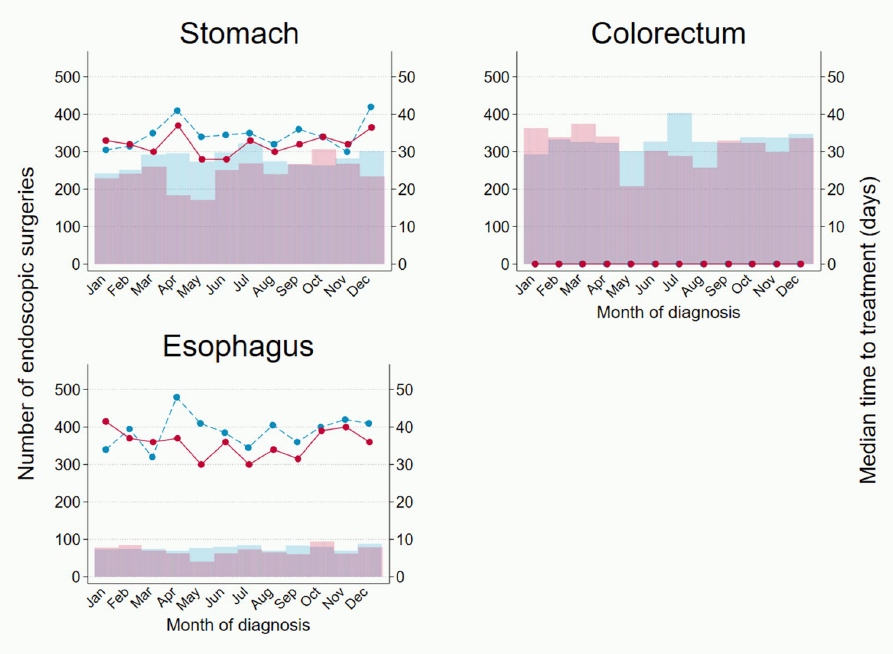
Fig 3. Number of endoscopic surgeries and median time to endoscopic surgery for stomach, colorectal and esophageal cancer. Bar graphs indicate number of endoscopic surgeries (left axis: blue 2019, pink 2020) and line graphs indicate monthly median time in days from diagnosis to endoscopic surgery (right axis: blue dash 2019, red solid 2020).